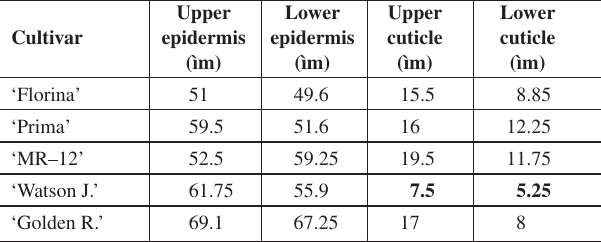
Table 1. Thickness of epidermal cells and cuticle in studied cultivars.